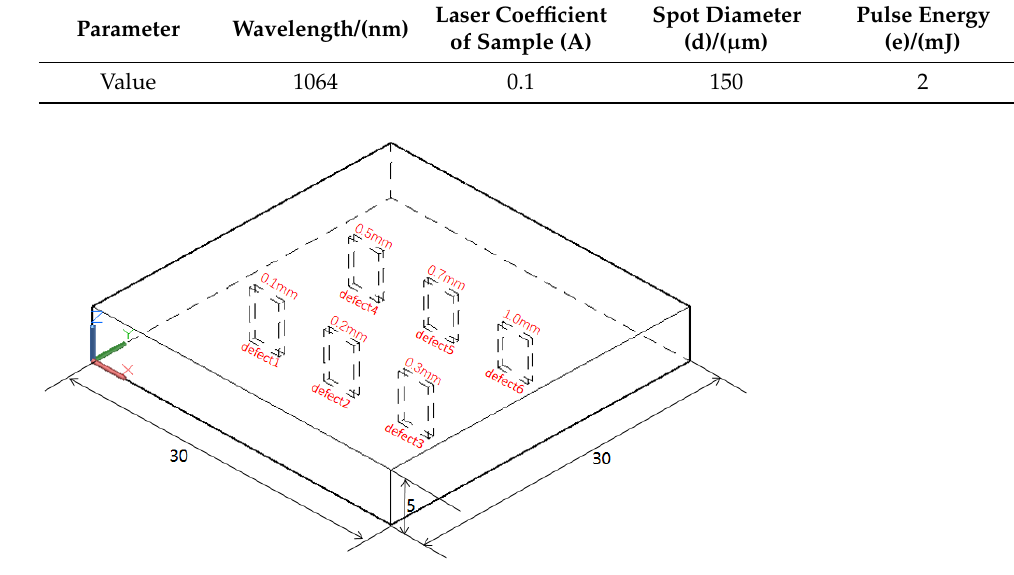
Figure 1. LGU testing system.